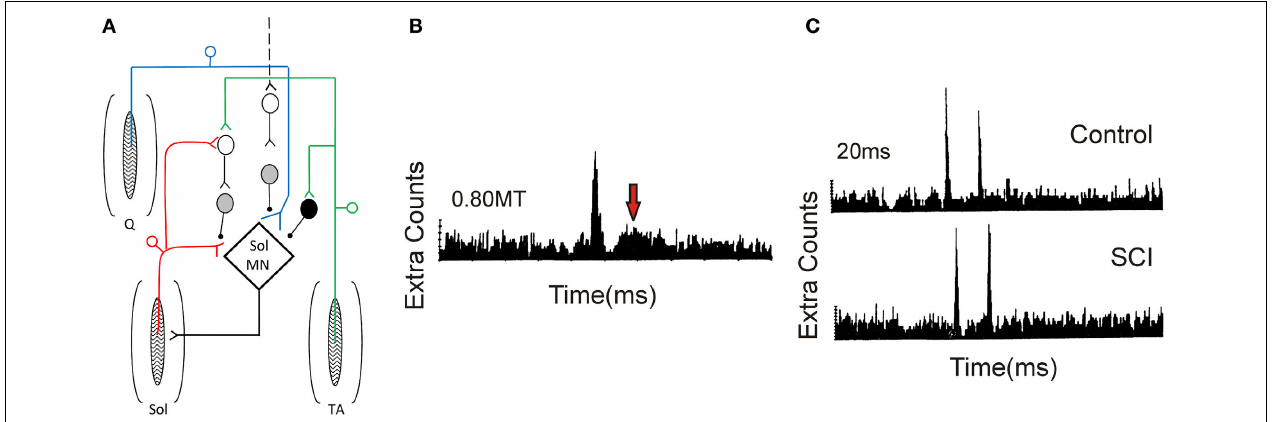
FIGURE 9 | Pre-synaptic and reciprocal inhibition in humans. (A) Pre-synaptic and reciprocal inhibitory pathways. Red trace : Monosynaptic Ia pathway to soleus (Sol, lower pathway) and homonymous activation of PAD interneurons (upper pathway). PAD interneurons marked by gray circles. Blue trace : Heteronymous, monosynaptic facilitation of soleus motoneurons by quadriceps (Q) Ia afferents that are tonically inhibited by PAD Ins, the latter activated by descending pathways (dashed line). Green trace : Reciprocal inhibitory pathway from tibialis anterior (TA) afferents onto soleus Ia reciprocal